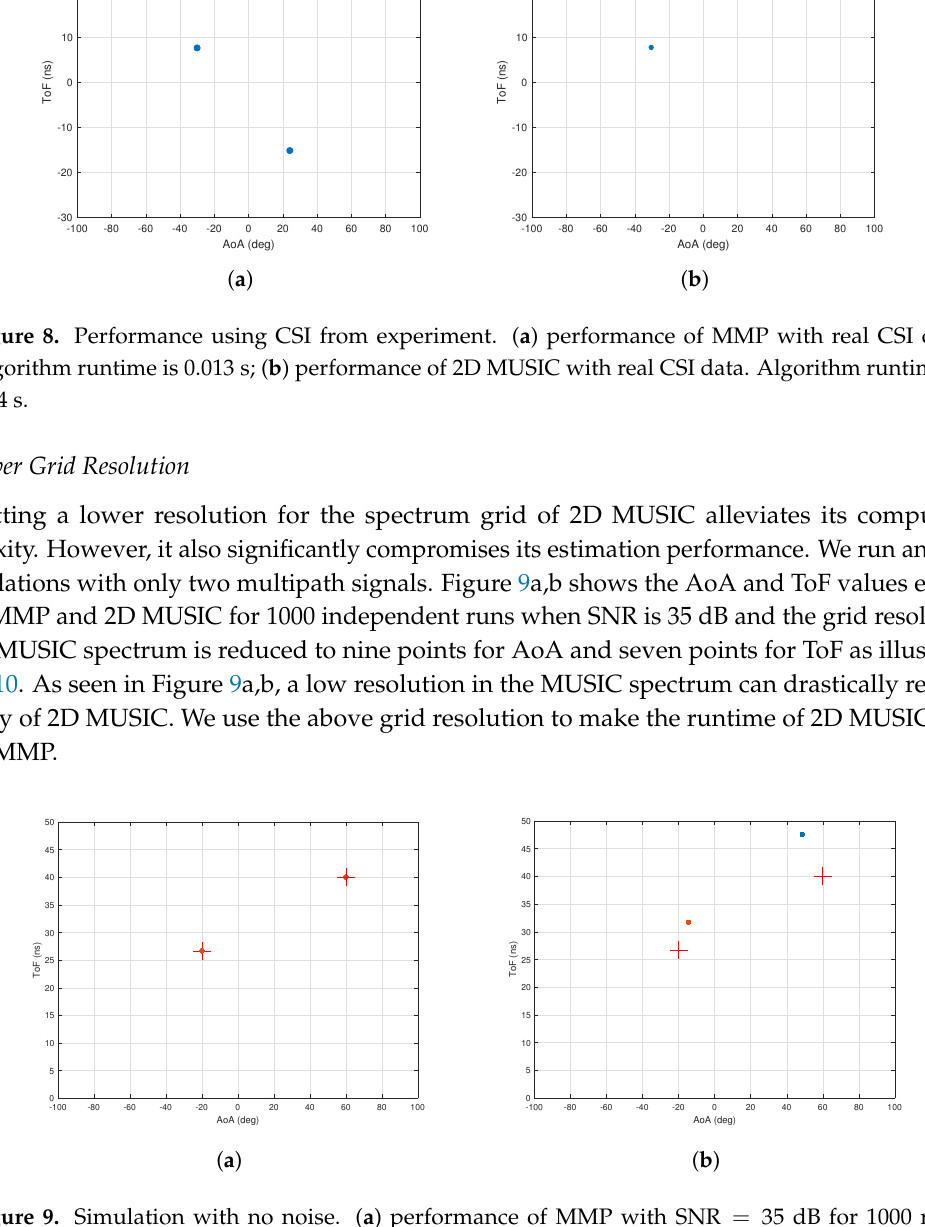
Figure 9. Simulation with no noise. ( a ) performance of MMP with SNR = 35 dB for 1000 runs. The RMSEs for AoA and ToF are 0.057 deg and 0.023 ns. Simulation time is 0.83 s; ( b ) performance of 2D MUSIC with SNR = 35 dB and a lower resolution grid for 1000 runs. The RMSEs for AoA and ToF are 8.4661 deg and 6.271 ns. Simulation time is 2.3